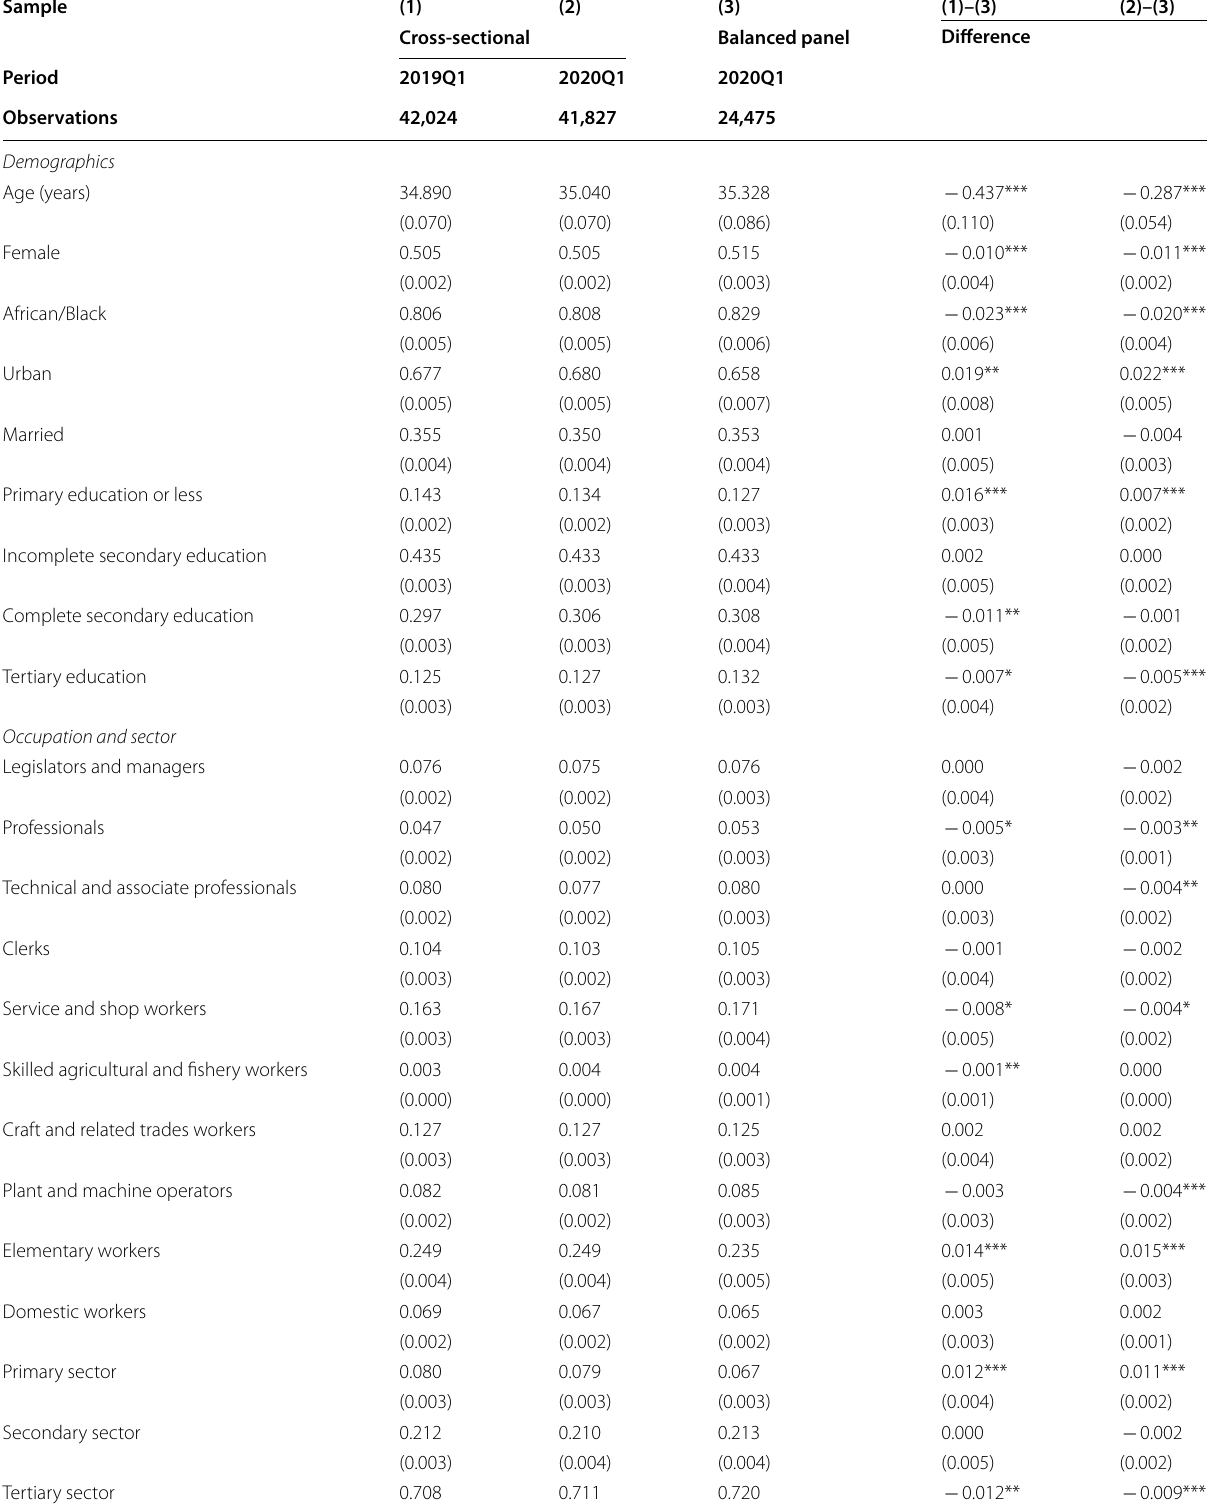
Table 1 Covariate balance table at baseline, by sample. Author’s own calculations. Source : QLFS 2019Q1, 2020Q1, and 2020Q2